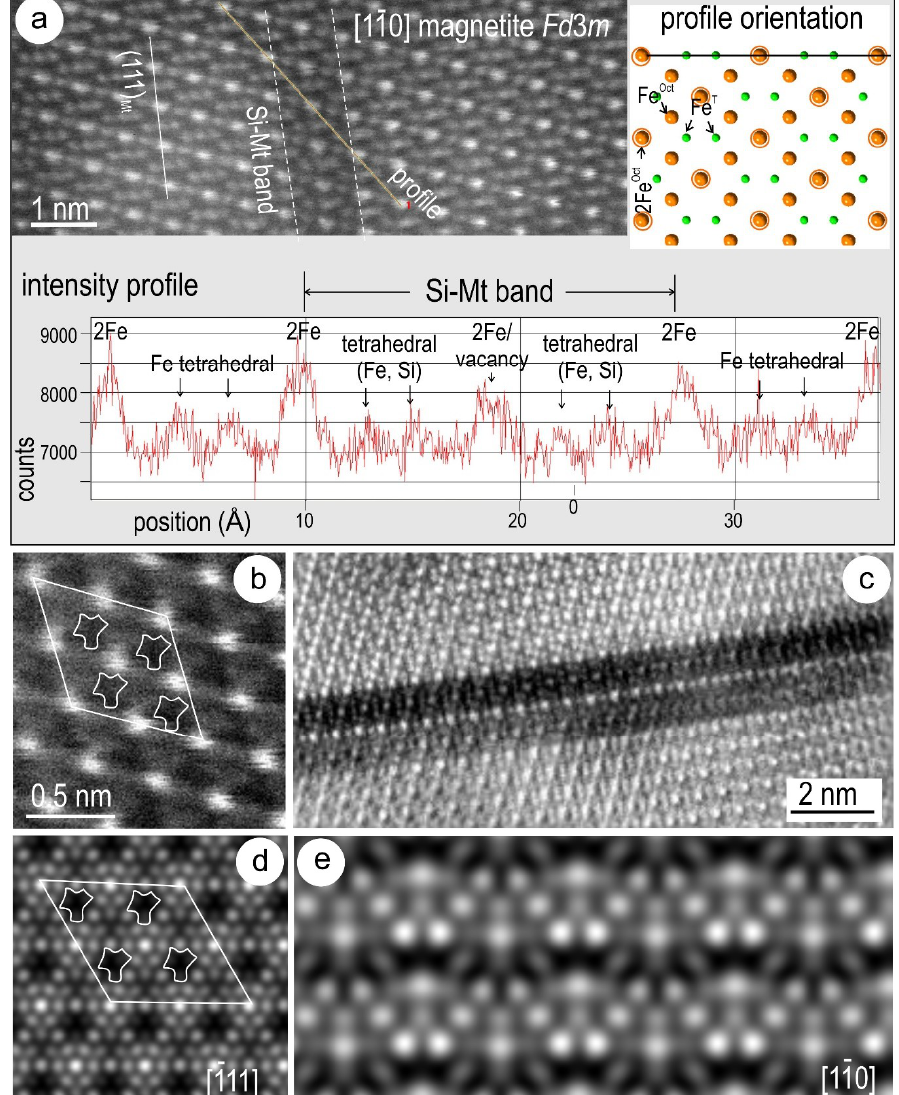
Figure 21. ( a ) HAADF STEM image (left) and profile (below) along orientation as marked on the crystal model (right) showing variation of HAADF signal intensity across the 2 d 111 nanoprecipitate (Si–Mt) in magnetite (Mt). This is compatible with vacancies in both T and M sites as suggested by DFT calculations for γ-Fe 1.5 SiO 4 [29]. ( b , c ) Detail of Si–Mt bleb [111] and 2 d 111 strip [110] with STEM simulations (using γ -Fe 1.5 SiO 4 [29]), shown underneath in ( d , e ) showing a relative good